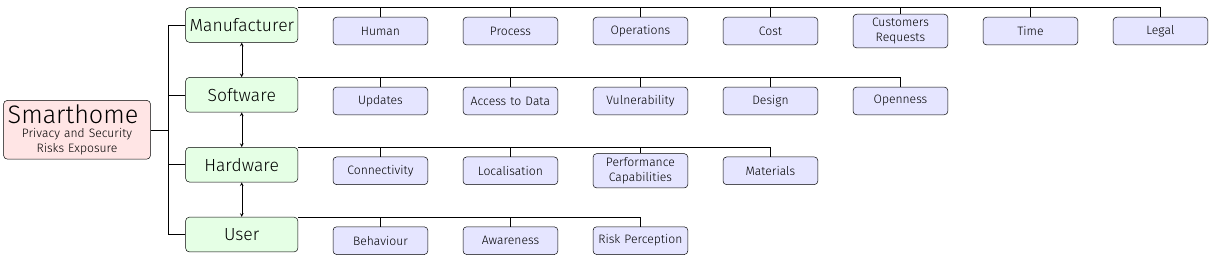
Figure 3. HHM for smarthome risk